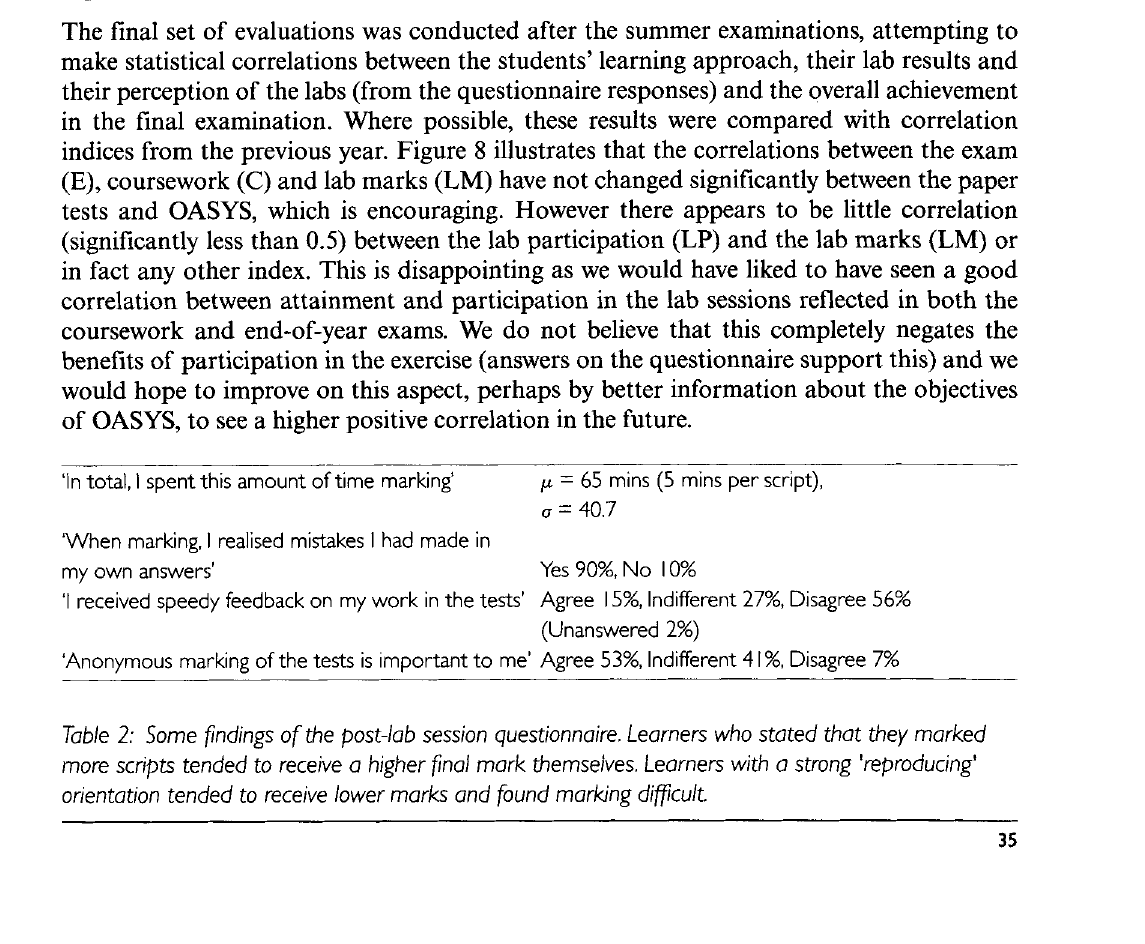
Table 2: Some findings of the post-lab session questionnaire. Learners who stated that they marked more scripts tended to receive a higher final mark themselves. Learners with a strong 'reproducing' orientation tended to receive lower marks and found markdng